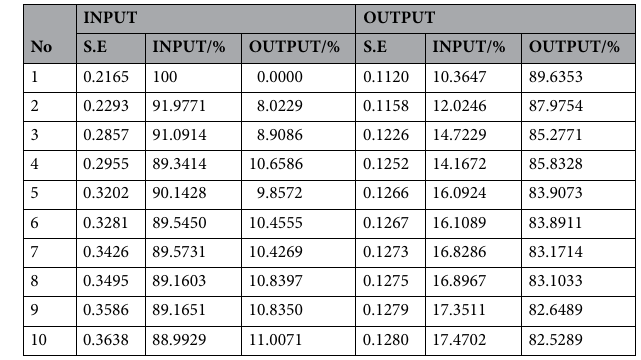
Table 10. Variance decomposition